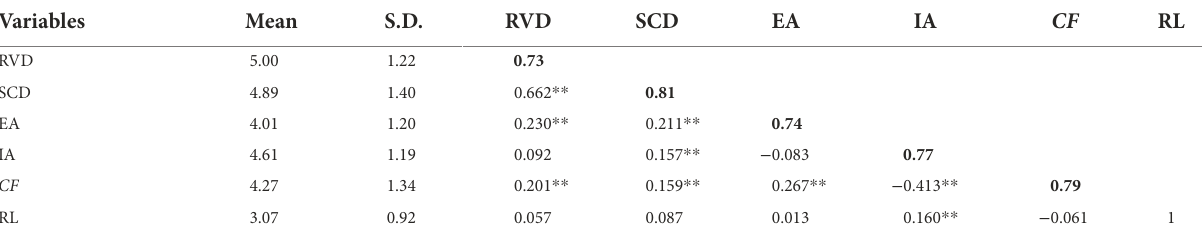
TABLE 5 Mean, standard deviations, and correlations of the constructs.